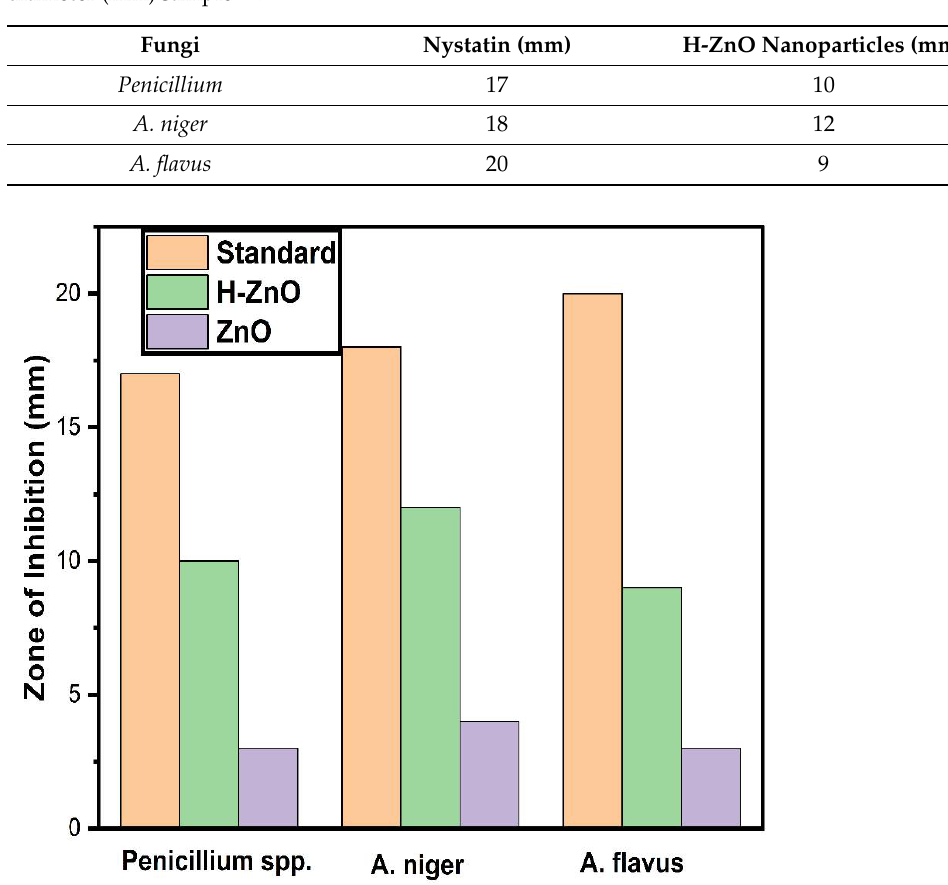
Figure 7. Antifungal activity of bare ZnO and H-ZnO nanoparticles compared to the standard antifungal agent nystatin. Table 2. Antifungal activity of H-ZnO nanoparticles on fungal species reported as zone of inhibition diameter (mm) sample −1 .